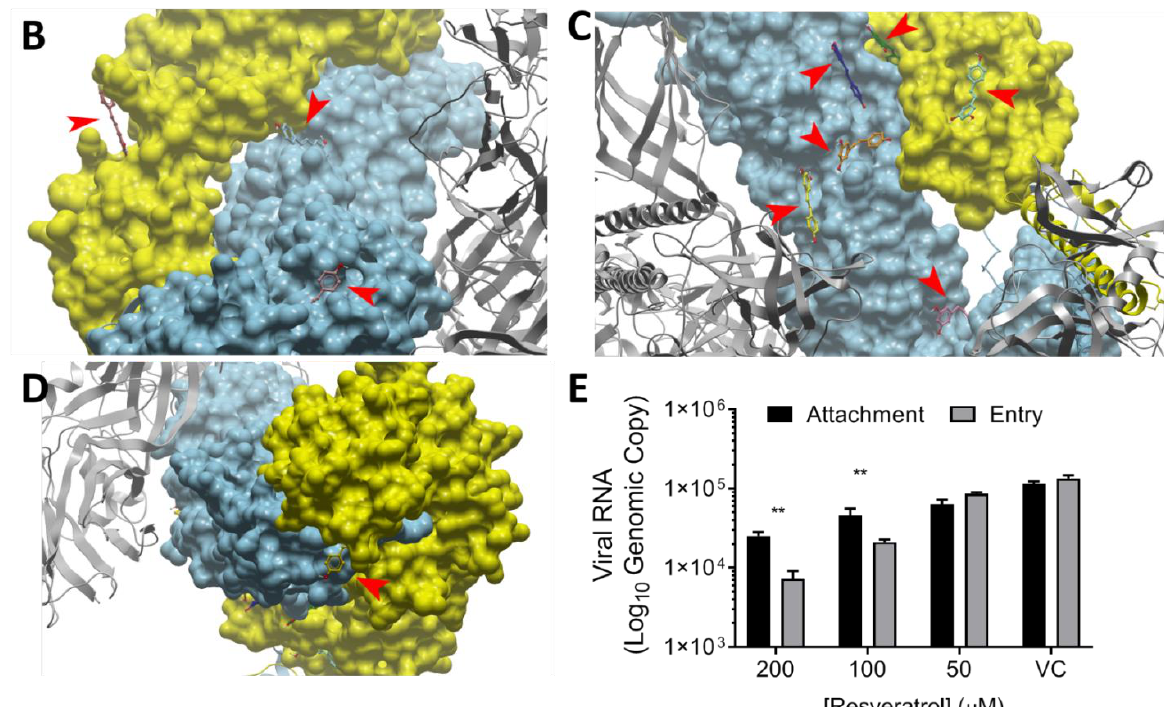
Figure 4. Interaction between resveratrol and VEEV envelope glycoproteins. ( A ) Overview of VEEV E1 and E2 proteins, indicating the viewing angles corresponding to the following panel ( B – D ). Red arrows indicate the positions of resveratrol, and E1 and E2 are labeled in indigo and gold, respectively. ( E ) Viral attachment and entry were determined by quantifying the VEEV RNA inside cells at 16 h.p.i. in the presence or absence of resveratrol. ** p < 0.01 compared to viral control (VC) by one-way ANOVA.